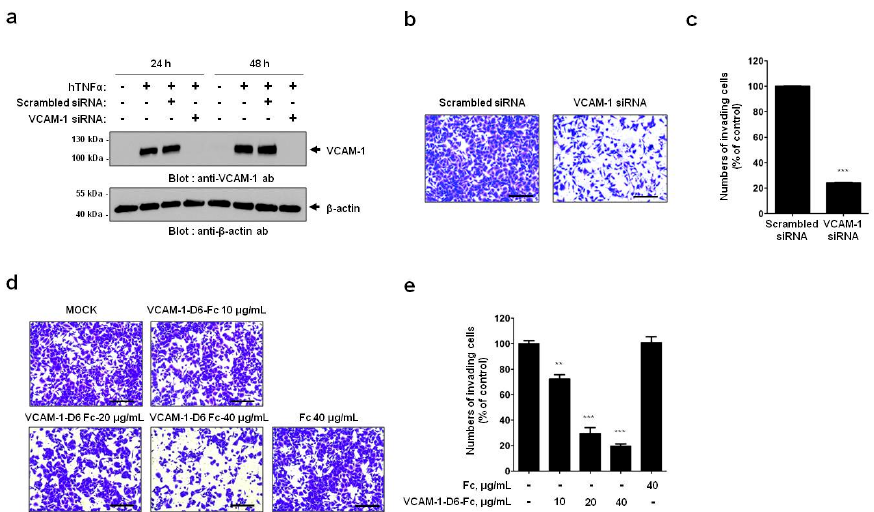
Figure 2. Modulation of VCAM-1 levels and function affect A549 lung cancer cell migration into Matrigel. ( a ) Representative immunoblots show the expression of VCAM-1 from scrambled siRNA- or VCAM-1 siRNA-transfected A549 cells cultured in the presence of hTNF α ; ( b ) Representative images depict the migration of the scrambled siRNA- or VCAM-1 siRNA-transfected A549 cells into Matrigel cultured in the presence of hTNF α (200 × magnification, scale bar = 200 µ m); ( c ) Migrating cells into Matrigel were quantified in the scrambled siRNA- or VCAM-1 siRNA-transfected A549 cell groups and expressed as a percentage of the control values. All values represent the mean ± SEM of triplicate measurements from one of three independent experiments (*** p < 0.001); ( d ) Representative images illustrate the migration of VCAM-1-D6-Fc- or Fc-treated A549 cells into Matrigel cultured in the presence of hTNF α (200 × magnification, scale bar = 200 µ m); ( e ) The numbers of migrating cells into Matrigel in the VCAM-1-D6-Fc- or Fc-treated A549 cell groups were counted and expressed as a percentage of the control values. All values represent the mean ± SEM of triplicate measurements from one of three independent experiments (** p < 0.01, *** p < 0.001).